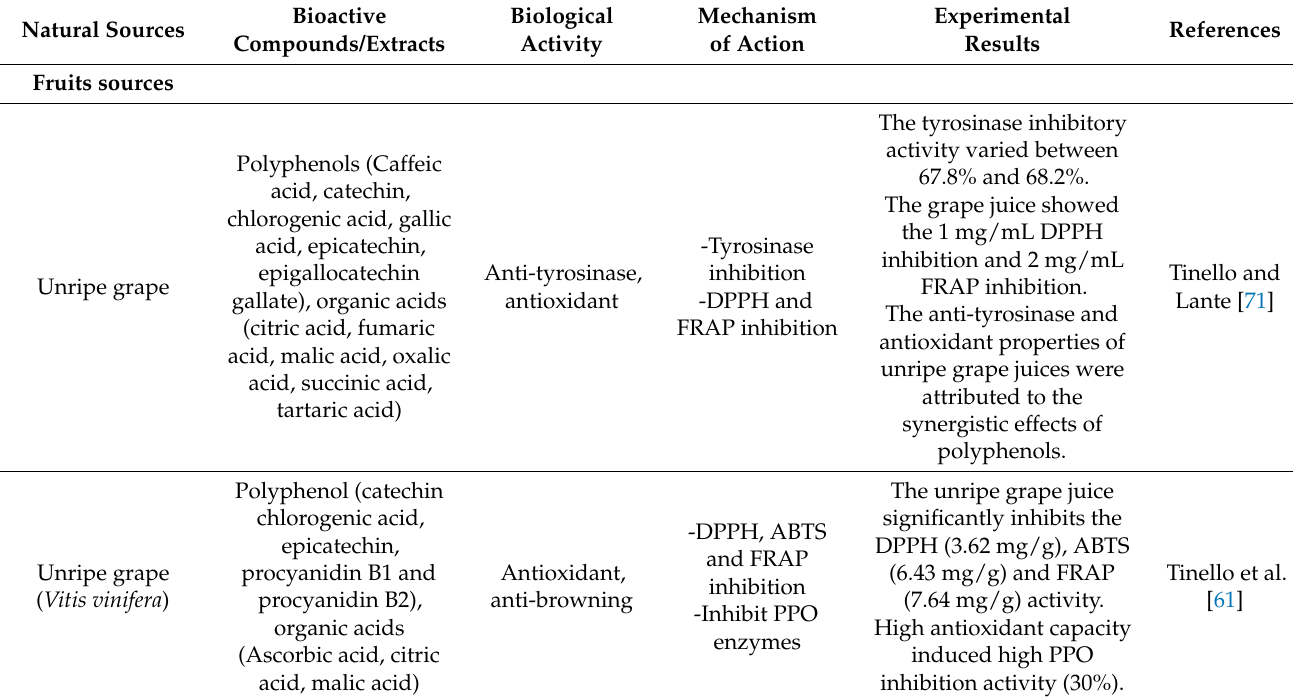
Table 1. Summary of most common natural sources from fruits, vegetables, plants/herbs, and others in market and their anti-browning properties reported within the last ten